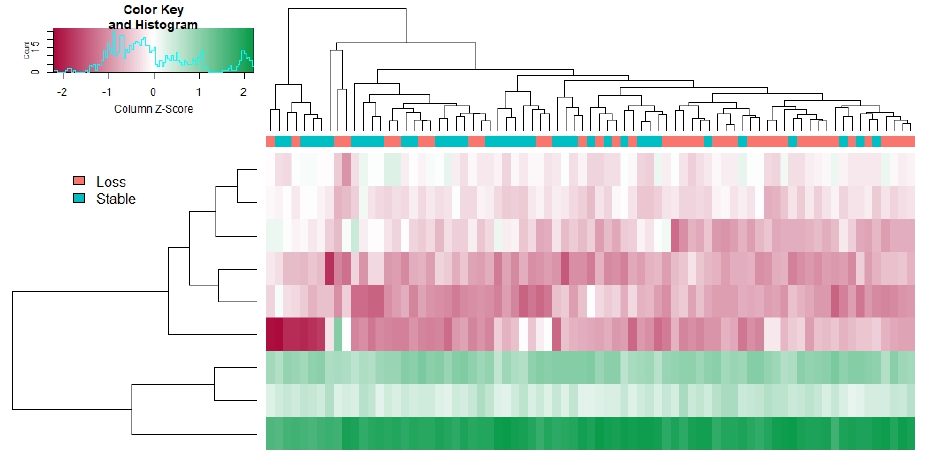
Figure 2. Change in mean metabolite abundance in weight loss group. The distribution with mean and inter-quartile ranges are shown for eight metabolites with nominally significant p -values in Welch’s t -tests between baseline and the end of the six-month weight loss intervention.